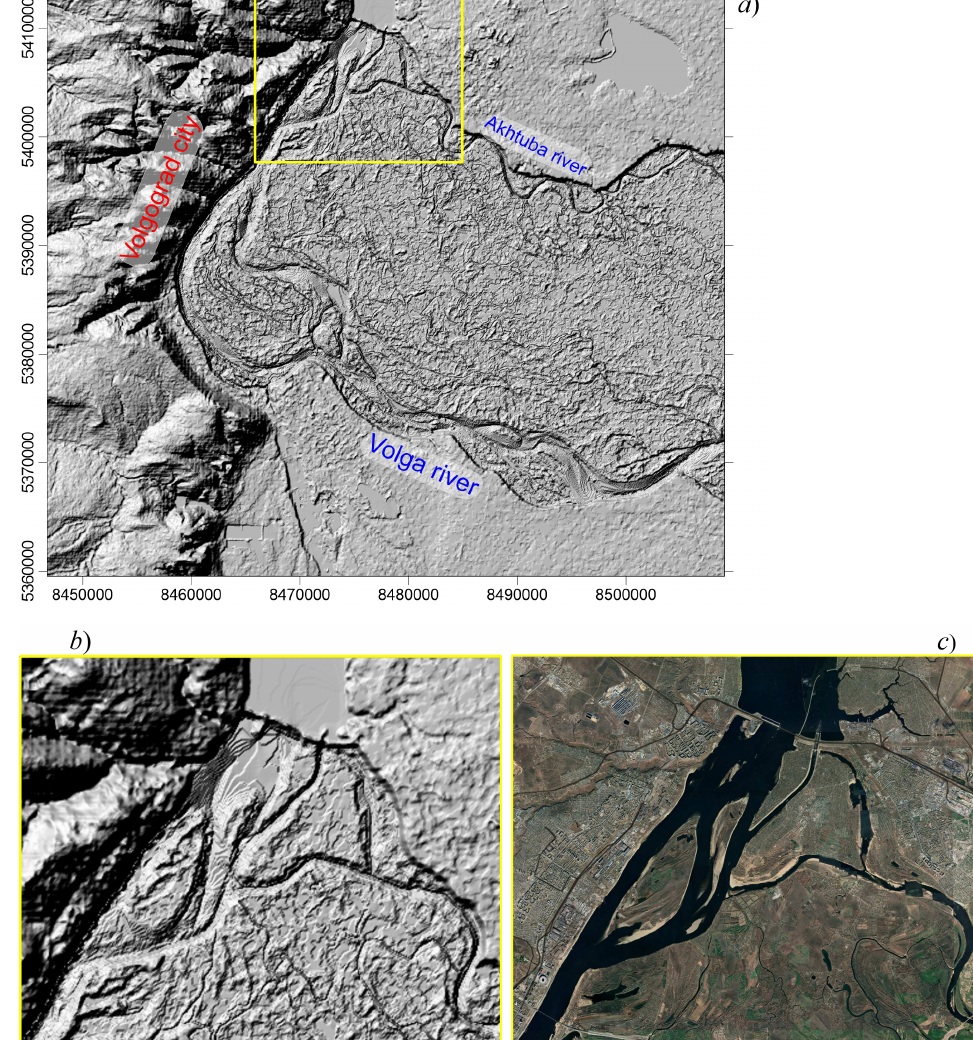
Figure 4. ( a ) DEM of the northern part of the VAF, 50 km by 60 km. Elevations are shown in the Shaded Relief Map model. Bottom: ( b ) DEM fragment highlighted with a yellow line on the main DEM ( a , c ) corresponding map of this zone (Google/Landsat-8 image). Long small channels are well traced in the interfluve of the Volga and Akhtuba